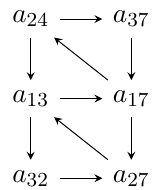
Figure 8. The initial cluster for Conf 7 ( P 3 ) labelled by homogenised A -coordinates.